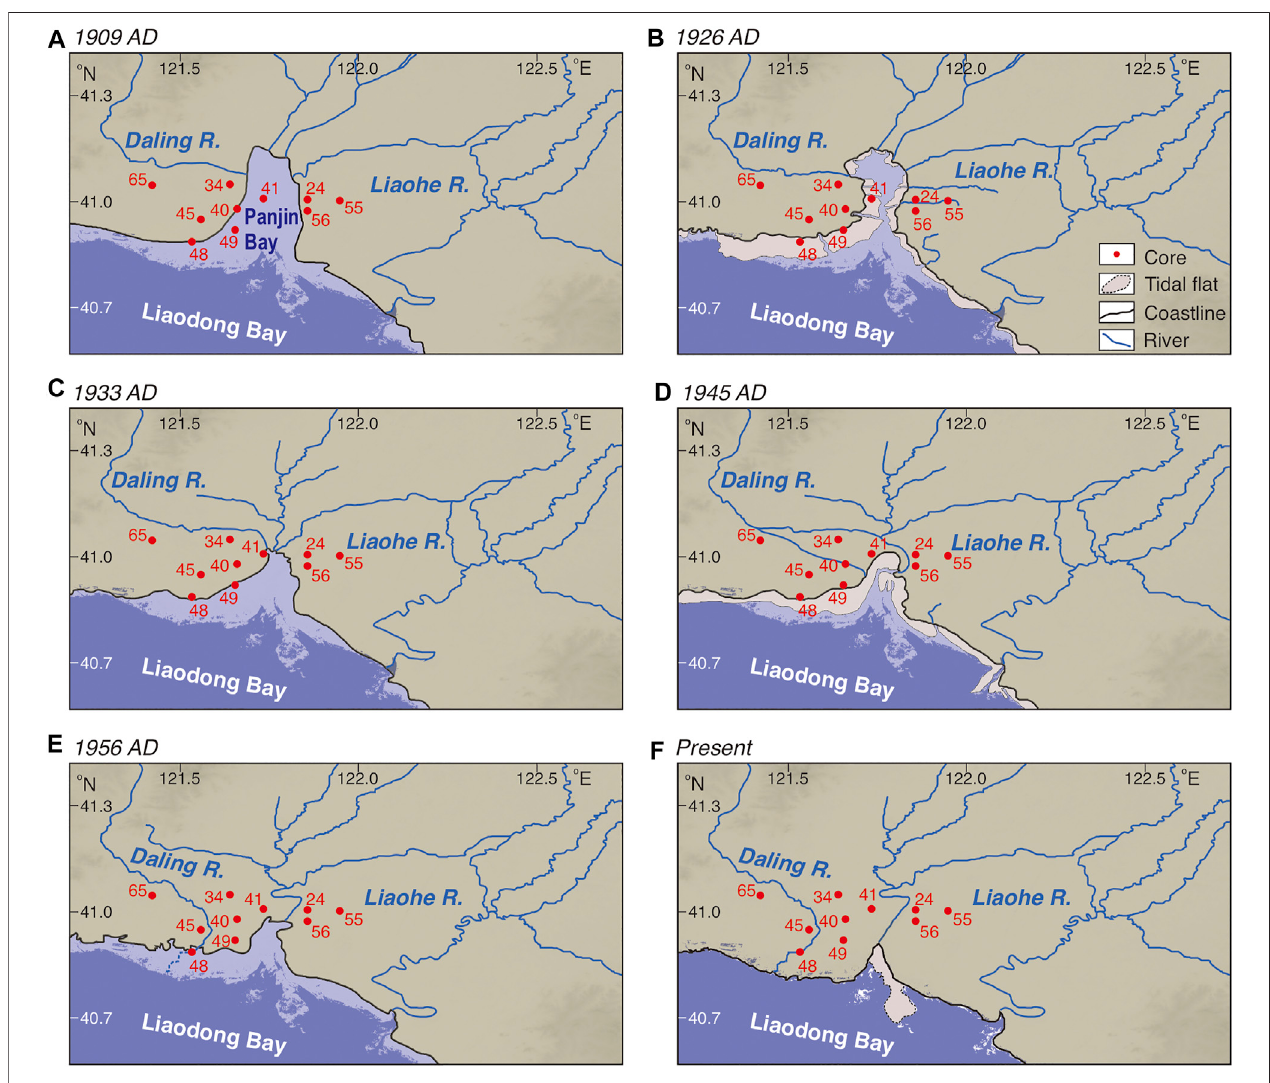
FIGURE 5 | Reconstructed coastline and river channels using the historical charts of 1909 (A) , 1926 (B) , 1933 (C) , 1945 (D) , and 1956 (E) AD. The present coastline and river channels are extracted from the ASTER digital elevation model (https://lpdaac.usgs.gov/).